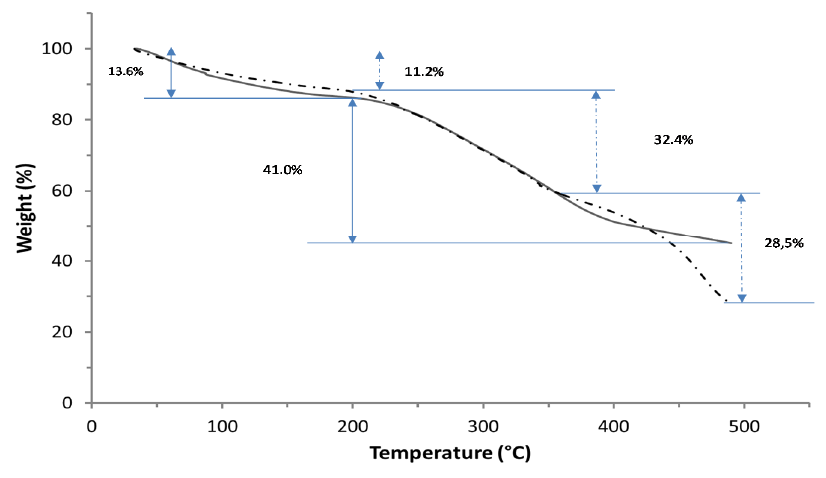
Figure 4. TGA curves of undialyzed (- · - · -) and dialyzed ( ____ ) PGA. Experimental details are given in the text.